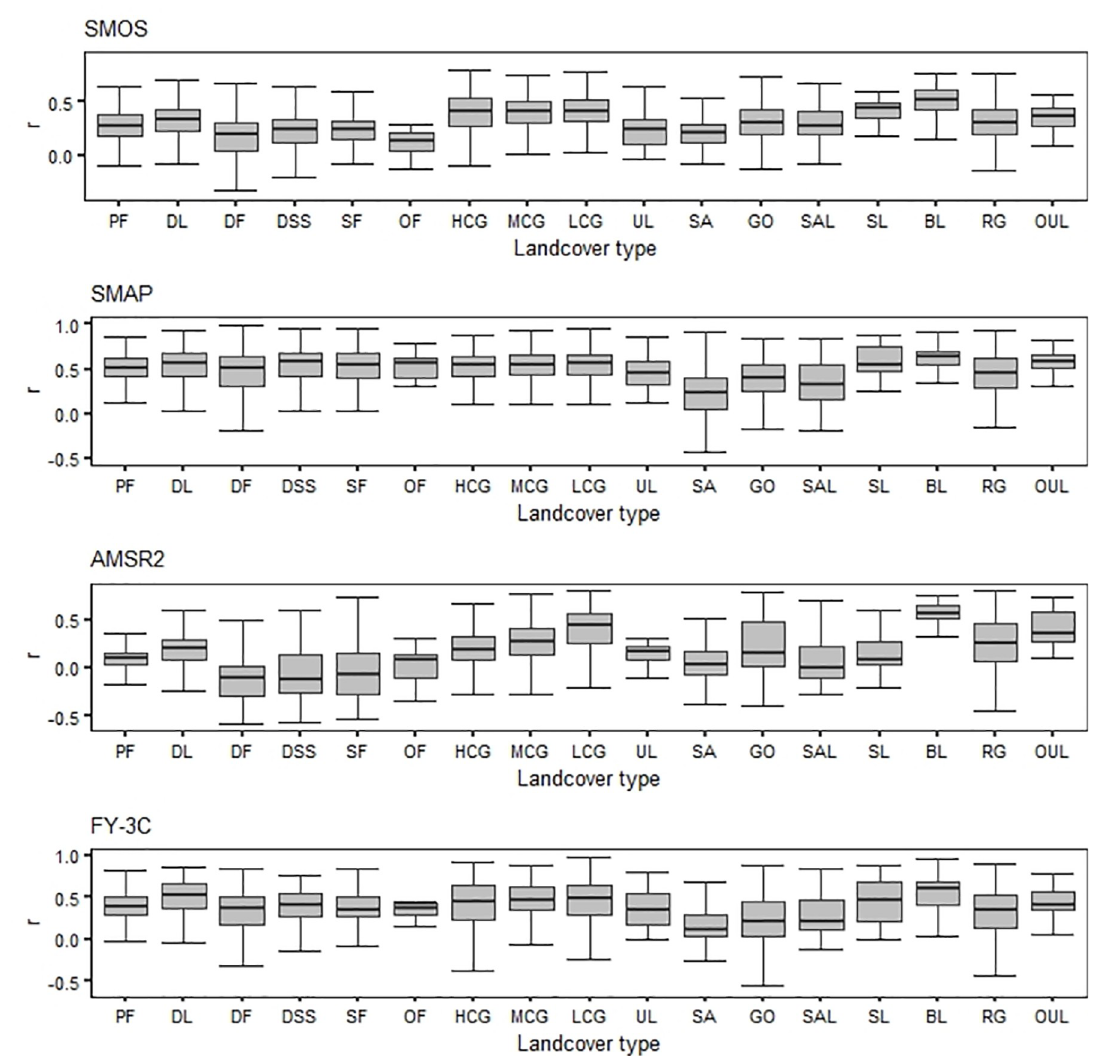
Fig 4. Boxplots of coefficients of correlation between SM data accuracy and land cover type for each product; abbreviations of landcover types are: PF paddy field, DL dry field, DF dense forest, DSS dwarf scrub and shrub, SF sparse forest, OF other forests, HCG high coverage grassland, MCG medium coverage grassland, LCG low coverage grassland, UL urban land, SA sand, GO Gobi, SAL saline alkali land, SL swampland, BL barren land, RG rock and gravel, OUL other unused land.